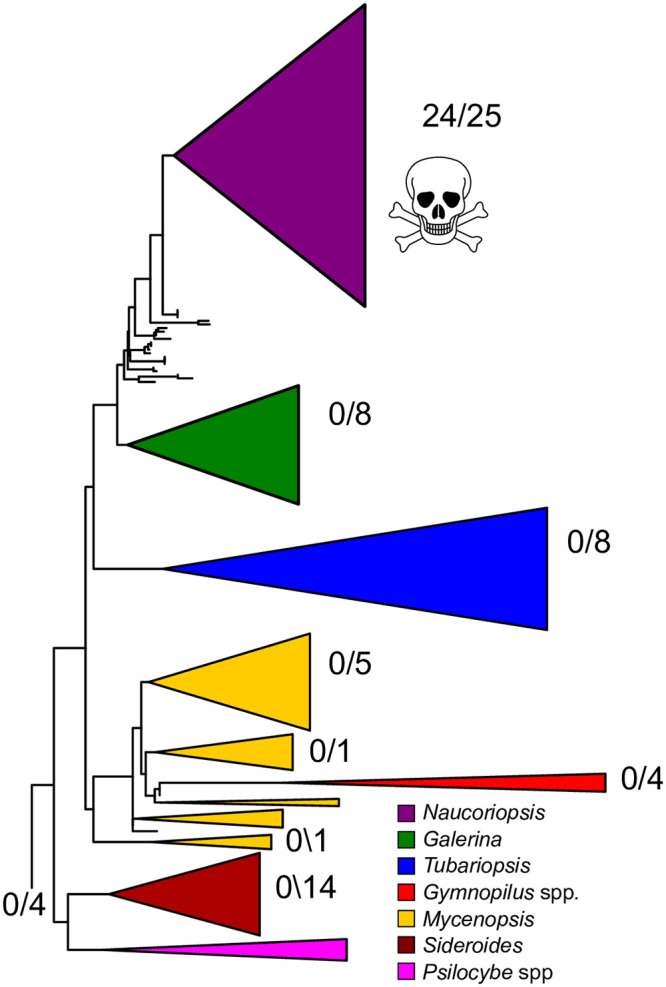
All 24 toxin-positive mushroom specimens are in subgenus Naucoriopsis of Galerina.We assayed for toxins in 70 collections representing 17 species of Galerina and 8 species in related genera. Each fraction is the number of samples positive for α-amanitin over the total number of specimens tested. Clade colors correspond to Galerina subgenera or to species of Gymnopilus and Psilocybe that appear nested in Galerina (S3 Table).